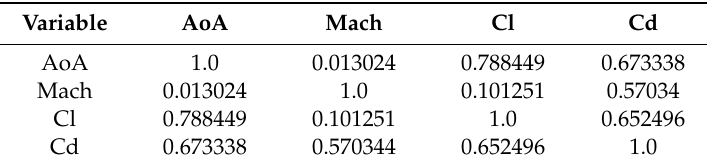
Table 6. Pearson correlation coefficients in NACA0012 databases.